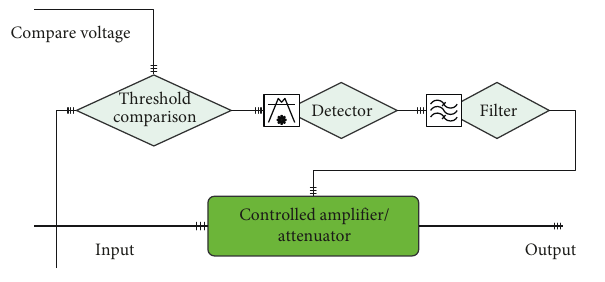
Figure 3: Open-loop automatic gain control.